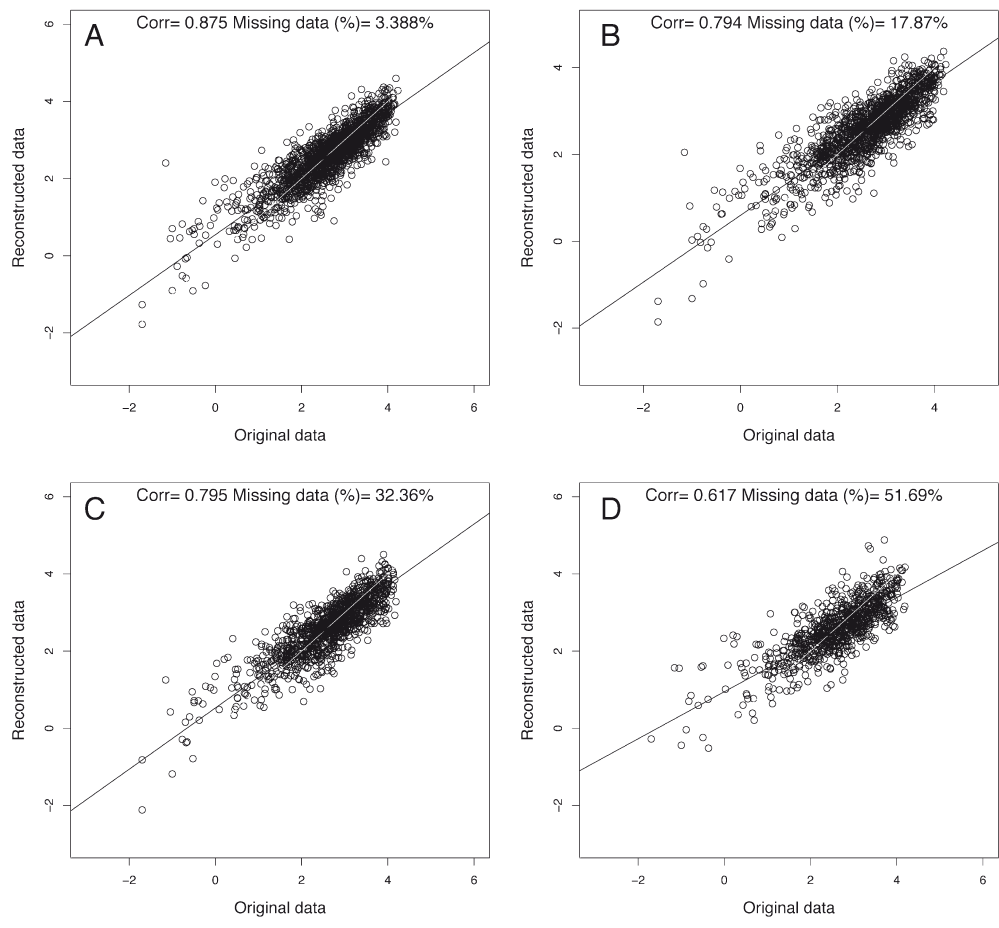
Fig . 7. – Comparison of reconstructed data with original data:A, 3.39% of missing data; B, 17.87% of missing data; C, 32.36% of missing data; and D, 51.69% of missing data. The diagonal line represents the fit corresponding to a linear model (line y=x).